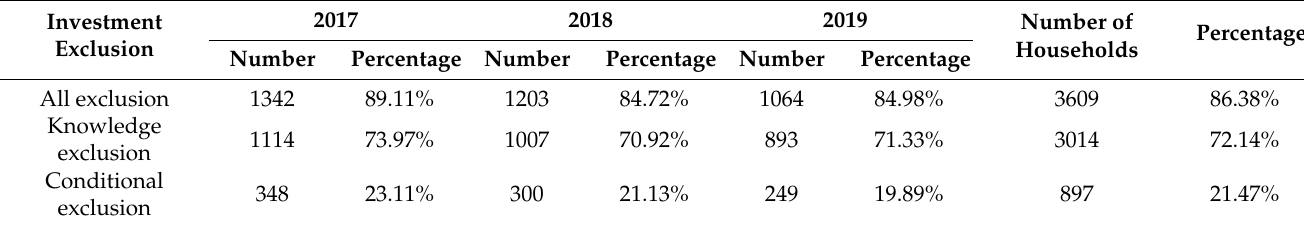
Table 3. The status quo of farmers facing investment exclusion.